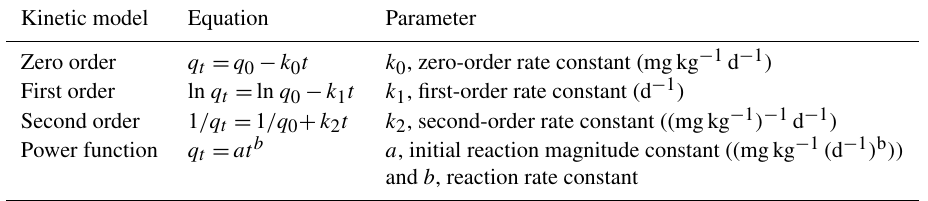
Table 4. Kinetic models used in the examination of chelated and non-chelated Zn fixation in the studied semi-arid alkaline soils of the Southern High Plains, USA.